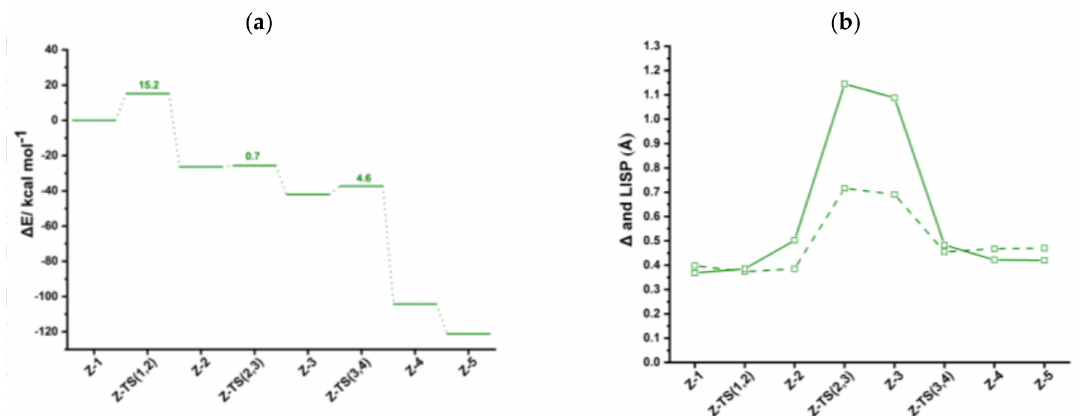
Figure 4. ( a ) Energy profile of acetylene [2 + 2 + 2] cycloaddition to benzene catalyzed by syn-IndRh (Scheme 3a, Path I). ( b ) Profiles of the slippage parameters (dashed line) and LISP (solid line) along the acetylene [2 + 2 + 2] cycloaddition cycle catalyzed by syn-IndRh (Scheme 3a, Path I). Level of theory: ZORA-BLYP /